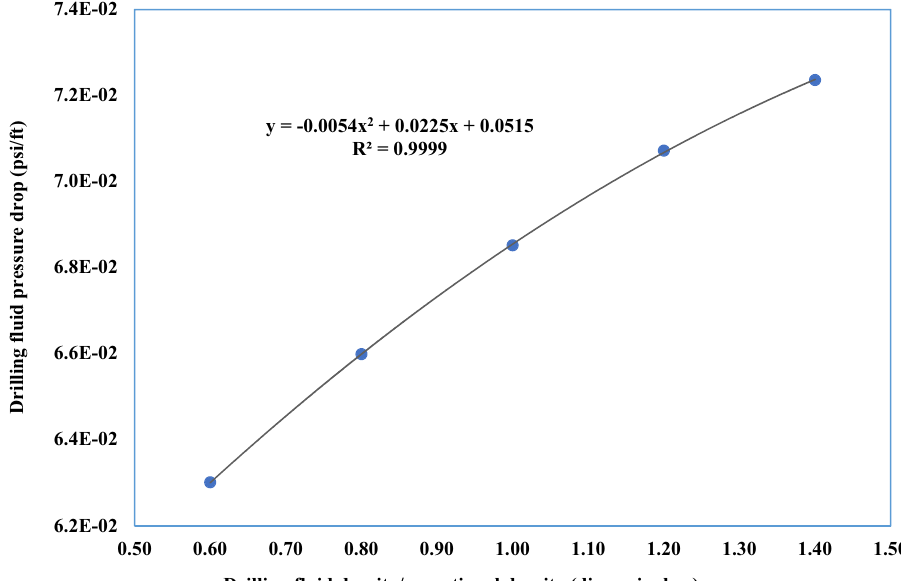
Fig. 17 Cutting precipitation in the annulus versus drilling mud density